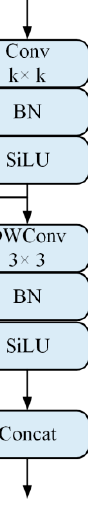
Figure 5. The GhostConv